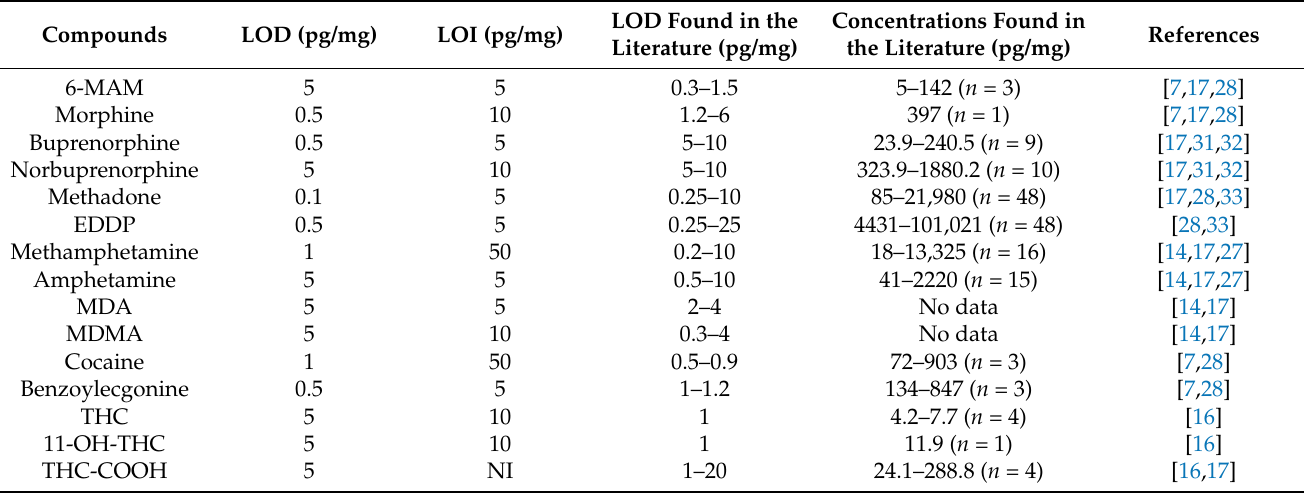
Table 2. Limit of detection (LOD) and limit of identification (LOI) observed for the 15 compounds, LOD retrieved in previous studies and